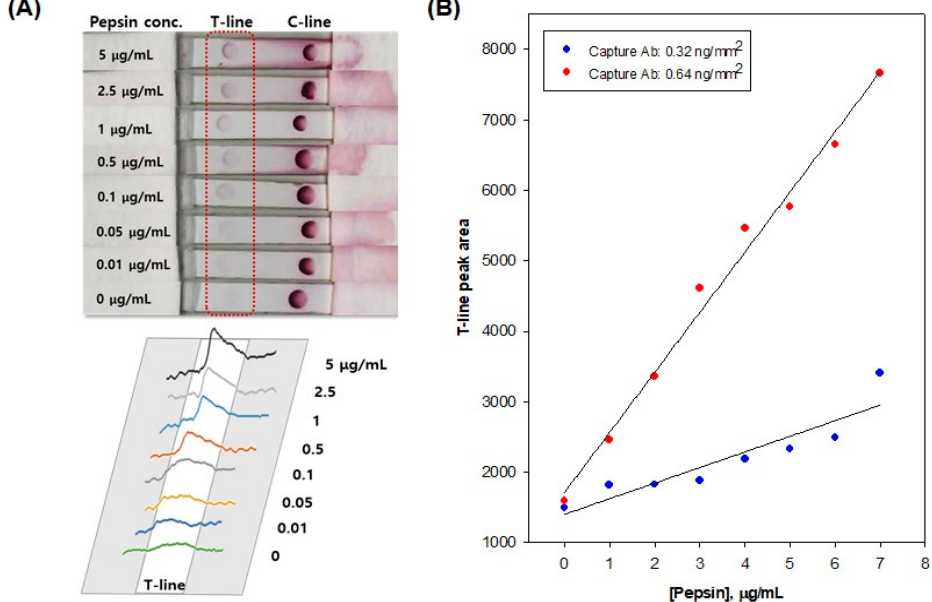
Figure 5. Evaluation of the analytical performance of the pepsin immunochromatographic strip sensor. Photographic images and signals analyzed by ImageJ software of immunochromatographic strips exposed to different levels of pepsin ( A ) and the calibration graph as a function of pepsin concentration ( B ).